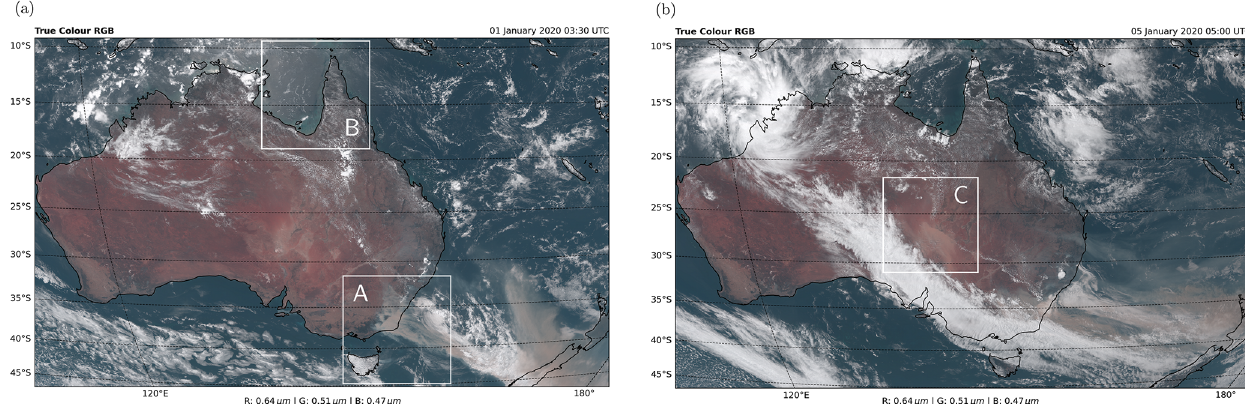
Figure 9. True-colour RGB false-colour composites from AHI scenes over Australia for (a) 1 January 2020 at 03:30UTC and (b) 5 Jan- uary 2020 at 05:00UTC showing the approximate areas of three case study regions. Region A contains an optically thick smoke plume on the SE coast of Australia, whilst region B contains a challenging scenario for cloud masks in the Gulf of Carpentaria. Region C contains a thick dust plume in central